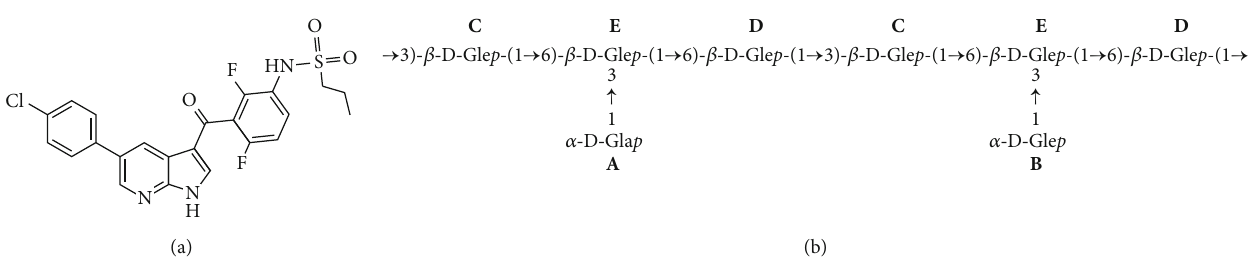
Figure 1: The molecular formula of Vemurafenib and the water-soluble component of macrofungal heteropolysaccharide (MFPS1): (a) Vemurafenib; (b)